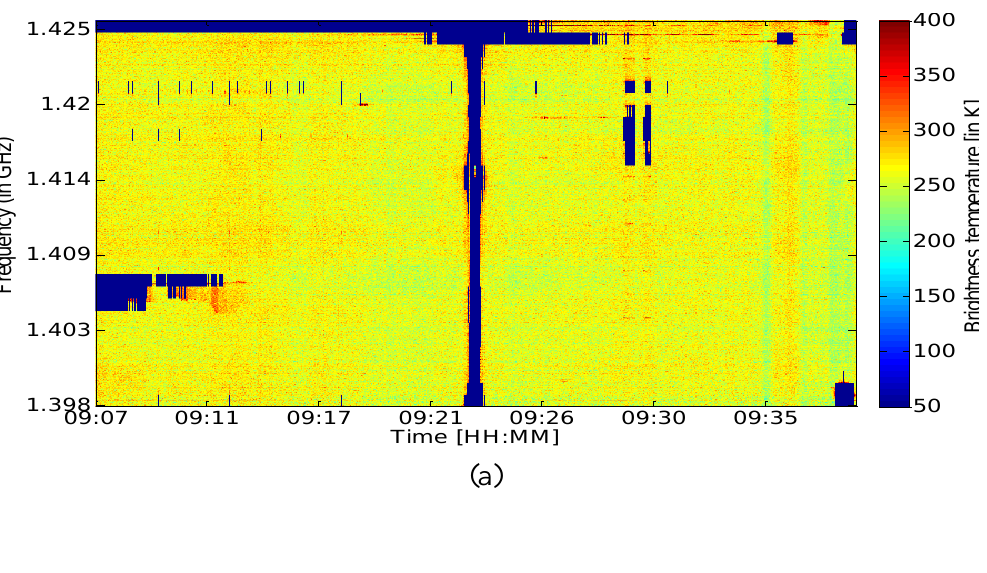
Figure 7. Brightness temperatures after correction using the Euclidian Filter, when the spectrum is divided into 32 sub-bands. The full set of data is shown in (a) , whereas an enlarged view of the pulsed RFI, before and after blanking, can be seen in (b) and (c)